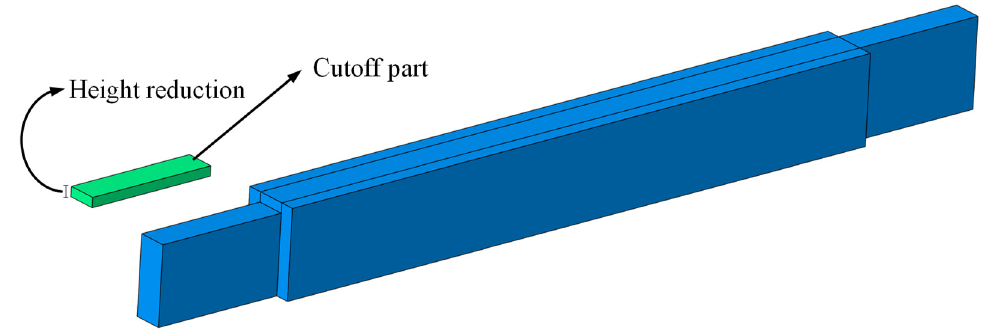
Figure 20. Damage in the top of the tenon.